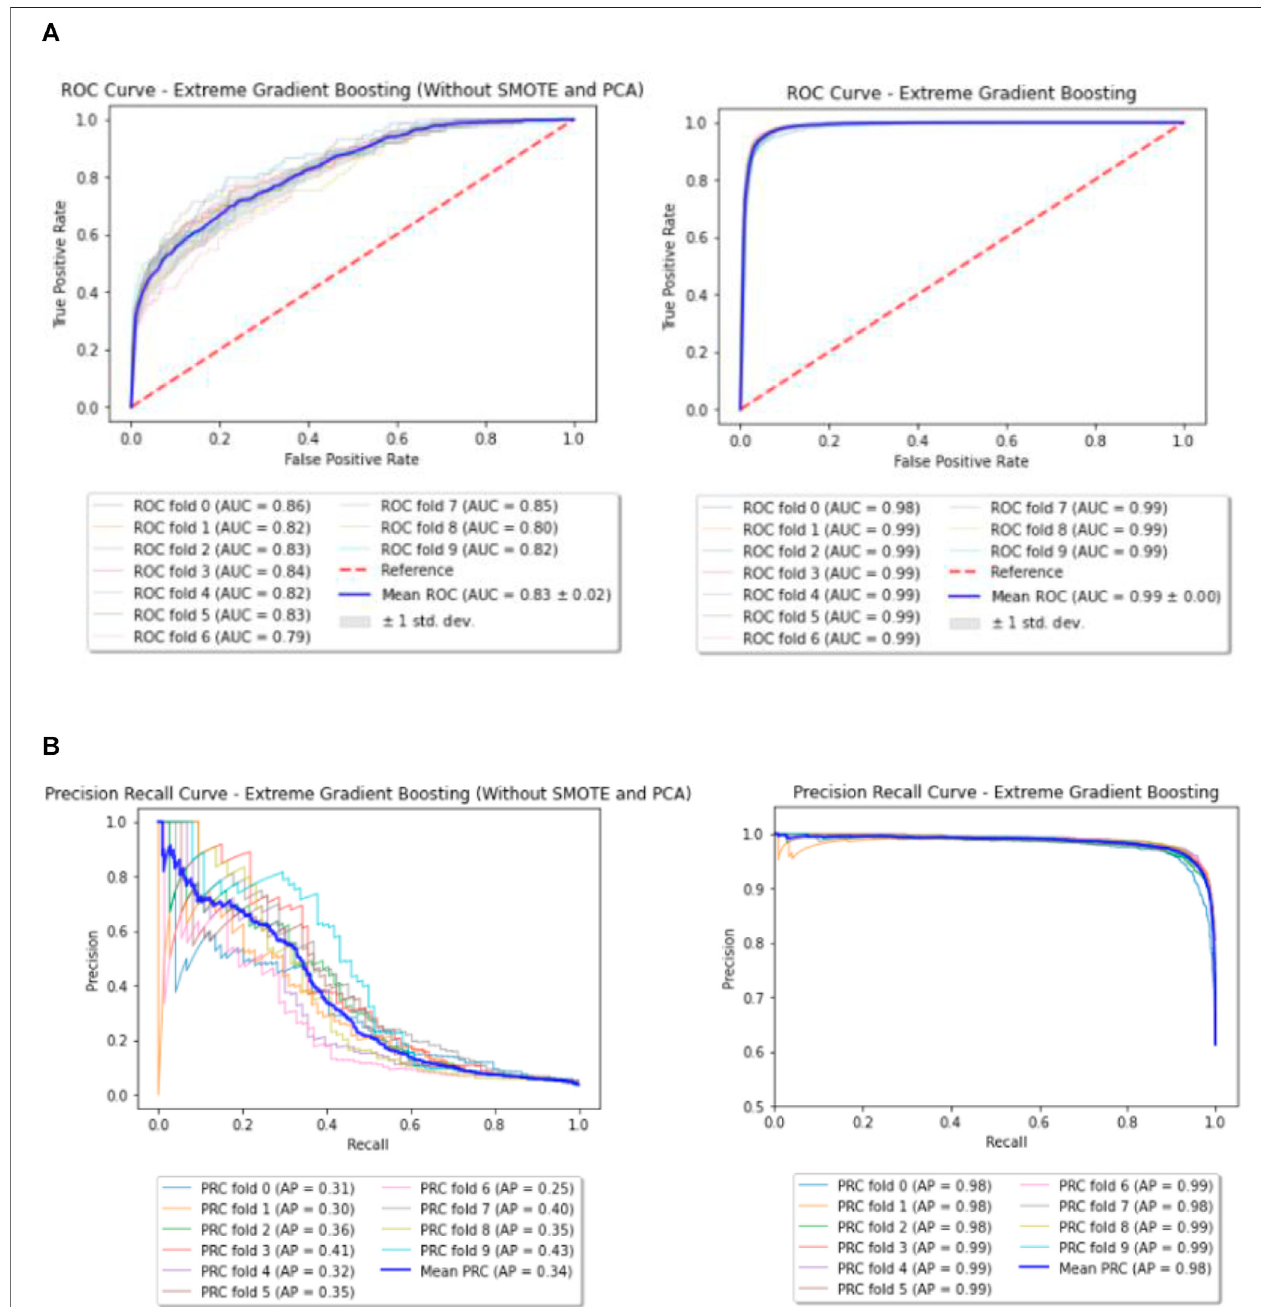
FIGURE 4 | (A) Enhanced model — ROC curves (before and after performing SMOTE and PCA). (B) Enhanced model — Precision Recall (PR) curves (before and after performing SMOTE and PCA).